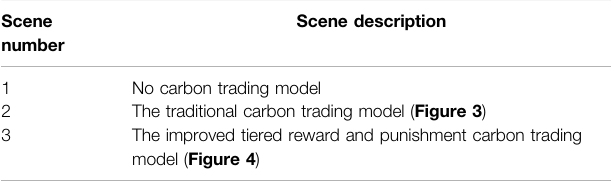
TABLE 4 | Carbon trading